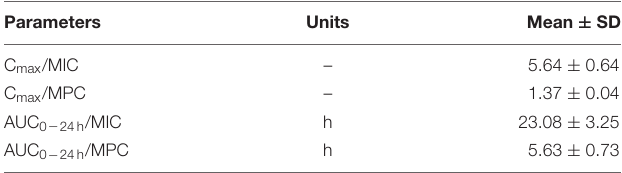
TABLE 2 | The main PK/PD integration parameters for MBF in ileum content after a single oral dose of MBF (2 mg/kg). Parameters